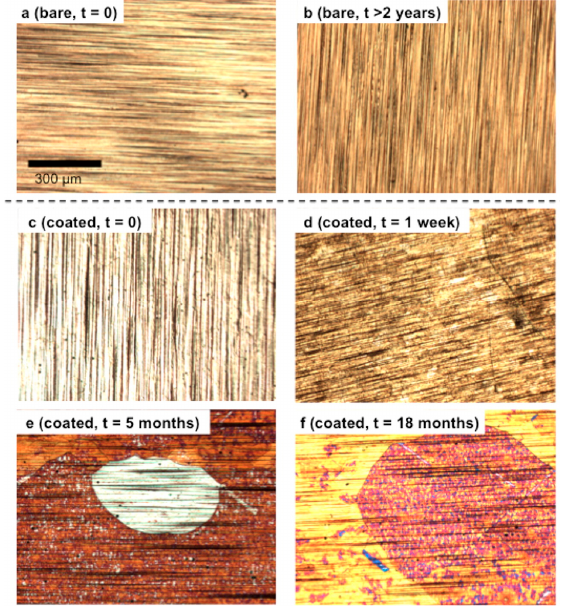
Figure 13. Optical images showing the effect of time on corrosion graphene-coated Cu in atmospheric condition. ( a ) Oxide-free (H 2 annealed) bare Cu; ( b ) Severe corrosion after 2 years; ( c ) graphene-coated Cu at t = 0 s; ( d ) Gr/Cu after 1 week showing no corrosion; ( e ) Gr/Cu after 5 weeks showing most of Cu corroded. However, due to strong graphene and Cu interaction, some grains remain protected; ( f ) After 18 months, the entire metallic surface is corroded including the previously protected grains. Reprinted with permission from ref. [138]. Copyright 2013 American Chemical Society.